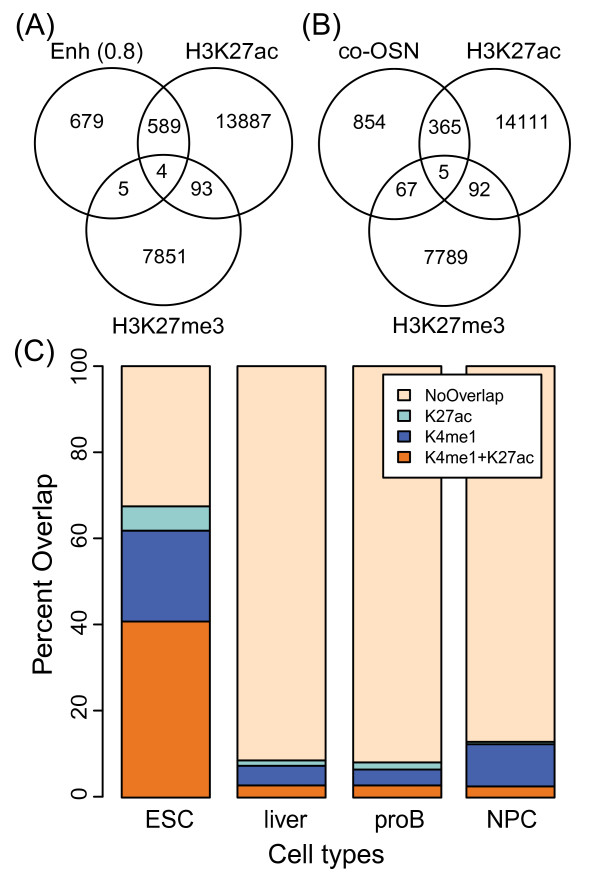
Enhancer candidates overlap ES cell specific H3K27ac and H3K4me1 modifications.(A) Venn diagram depicting overlap of high confidence Enh candidates (probability ≥ 0.8) with distal (TSS +/− 1 kb removed) H3K27ac marks (active) and H3K27me3 marks (repressive). (B) Venn diagram depicting overlap of OCT4, SOX2, NANOG co-bound training regions with distal H3K27ac marks (active) and H3K27me3 marks (repressive). (C) The stacked bar plot shows the percent overlap of high confidence Enh candidates with distal H3K27ac/H3K4me1 in various cell types. The overlaps presented allow a 500 bp gap.